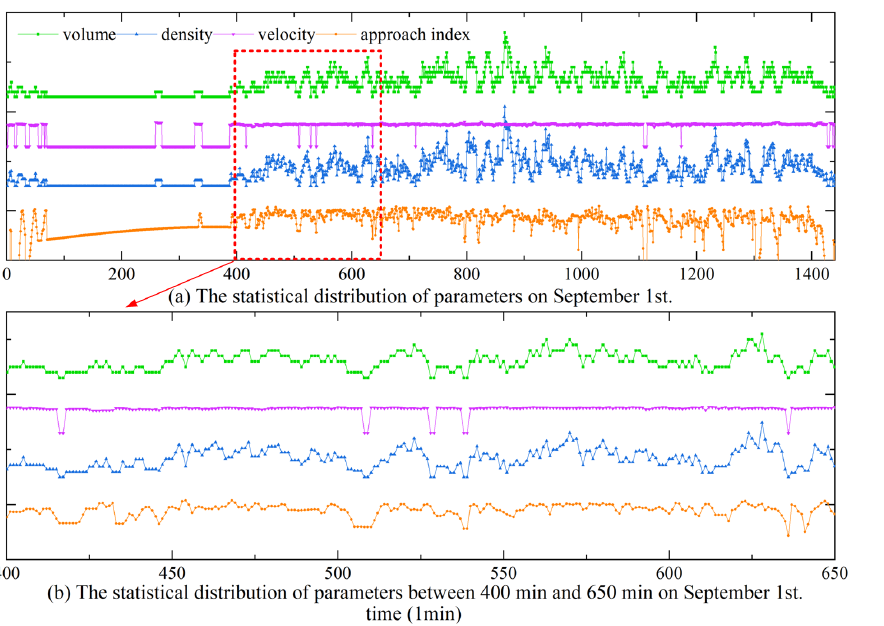
Figure 13. Traffic parameter time series. ( a ) The statistical distribution of paprameters on September 1st ( b ) The statistical distribution of parameters between 400 min and 650 min on Spetember 1st.